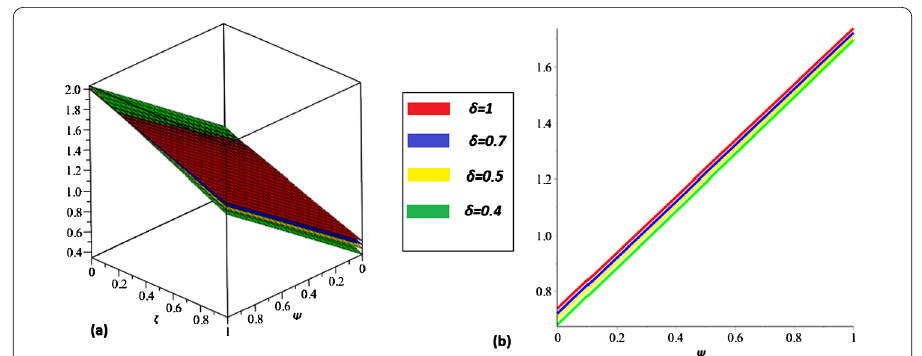
Figure 9 The ( a ) ETDM μ -solution of example 3 at different fractional orders of δ ( b ) ζ = 0.5